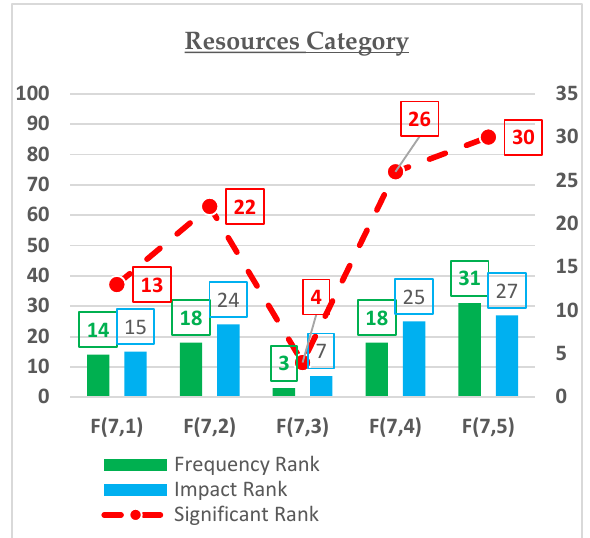
Figure 13. Significant risks in the resources category.